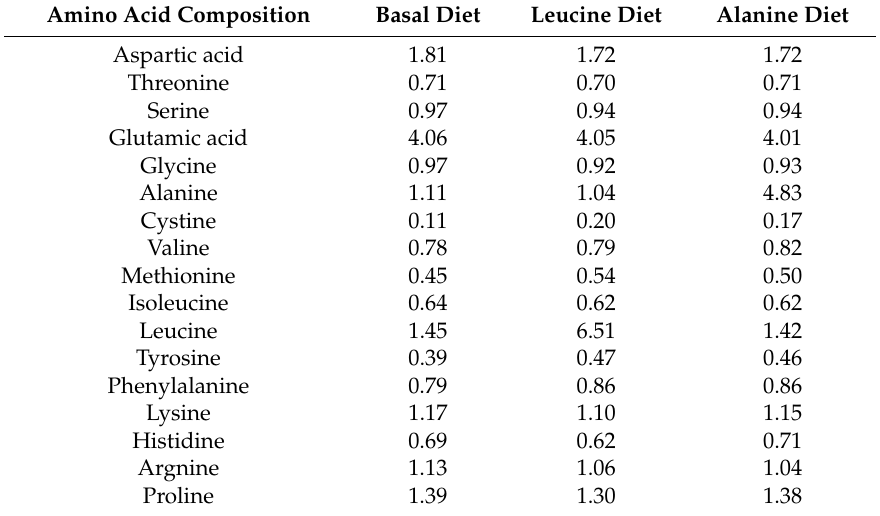
Table 2. Analyzed contents of amino acids (g/100 g) in the alanine- and